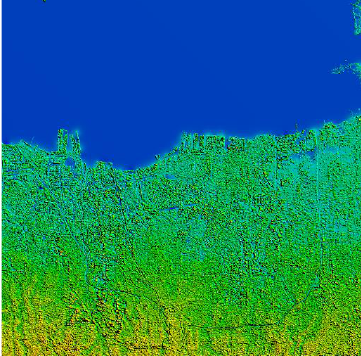
Figure 10. DEMNAS_1209-44_v1.0.tif. Figure 10. Table 5. BIG ’ s logo used on DCT and DFT.